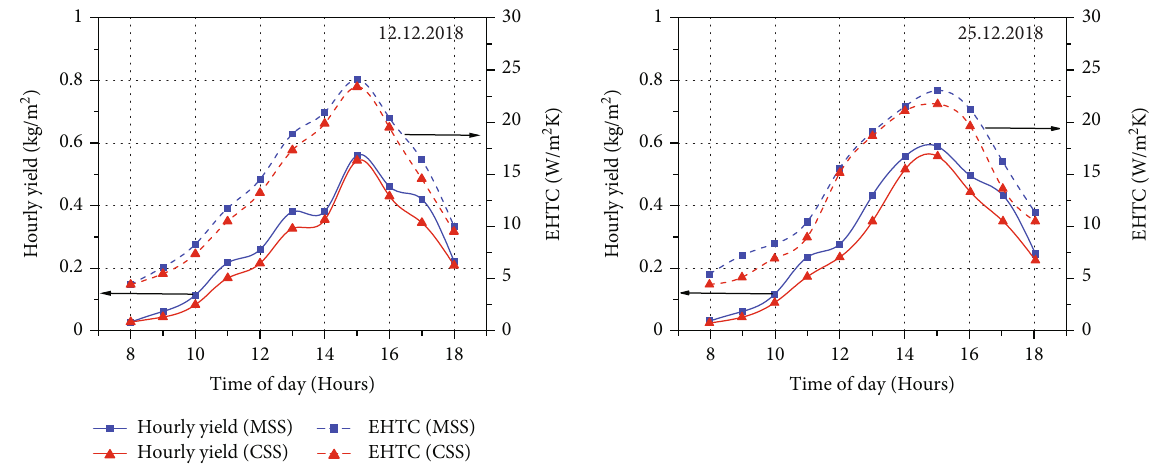
Figure 4: Variations in yield and EHTC from CBSS and